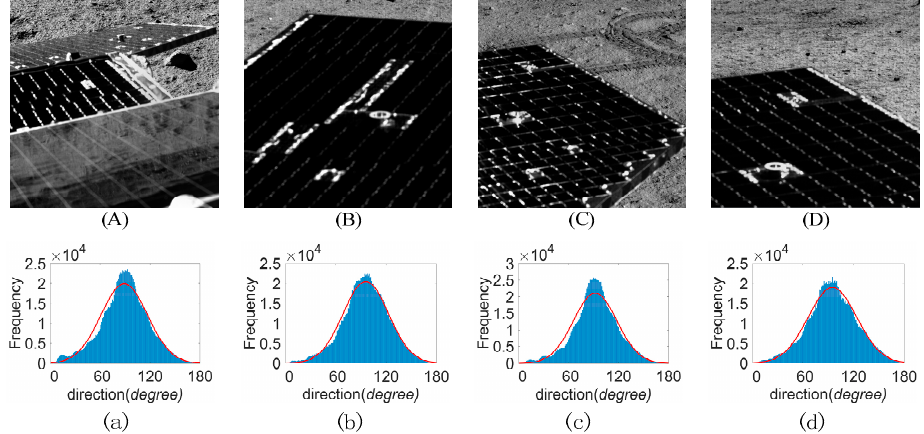
Figure 5. ( A – D ) are 4 original images taken by the Chang’e-3 navigation camera. ( a – d ) are the histograms of gradient directions corresponding to 4 images, the red curve in each figure is a Gaussian curve fitted by the statistical results of the histogram. In the histogram, the horizontal axis represents the gradient direction value and the vertical axis represents the number of occurrences.